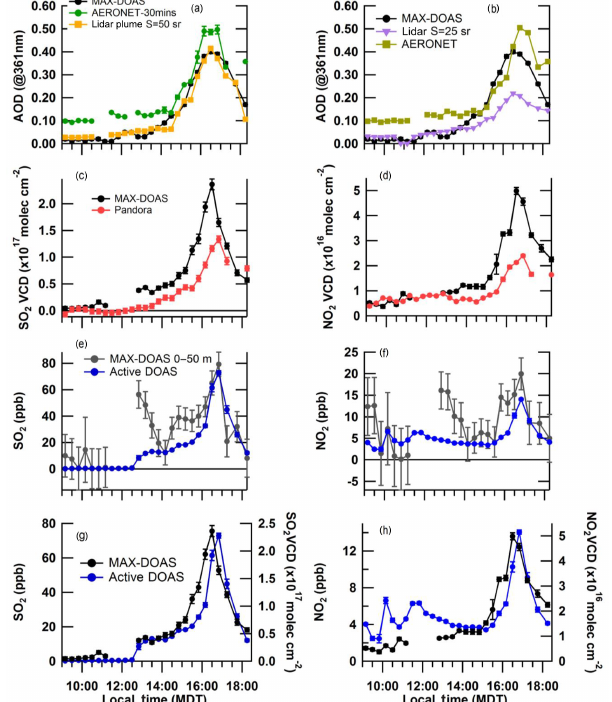
Figure 5. The 3 September AODs from MAX-DOAS, lidar, and AERONET (a) ; MAX-DOAS and Pandora SO 2 VCDs (b) ; MAX- DOAS and Pandora NO 2 VCDs (c) ; MAX-DOAS 0–100m and ac- tive DOAS SO 2 mixing ratios (d) ; MAX-DOAS 0–100m and ac- tive DOAS NO 2 mixing ratios (e) ; MAX-DOAS VCDs and active DOAS mixing ratios of SO 2 (f) ; and MAX-DOAS VCDs and ac- tive DOAS mixing ratios of NO 2 (g) . MAX-DOAS error bars were obtained from the optimal estimation retrieval. Error bars on the li- dar and AERONET AODs are the standard error of the temporally averaged values. Error bars on the Pandora VCDs and active DOAS mixing ratios are root-sum-square errors of the standard error from averaging and instrumental precision and the DOASIS retrieval er- ror, respectively. See Sect. 2.3.3 for